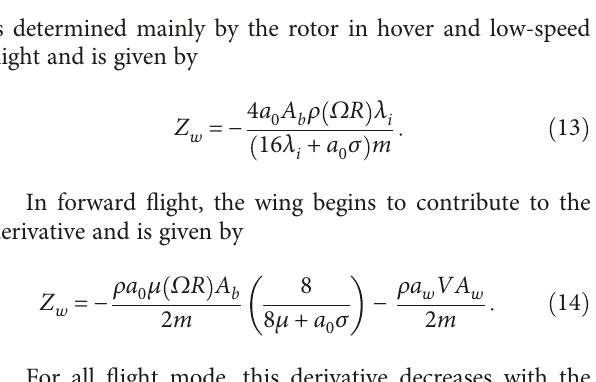
with forward speed. p